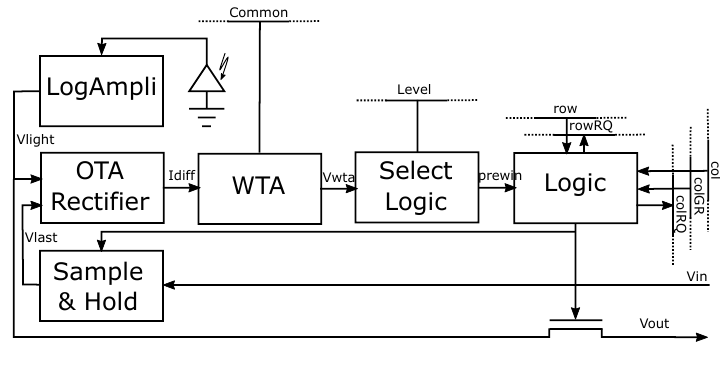
Figure 3. Basic SCD